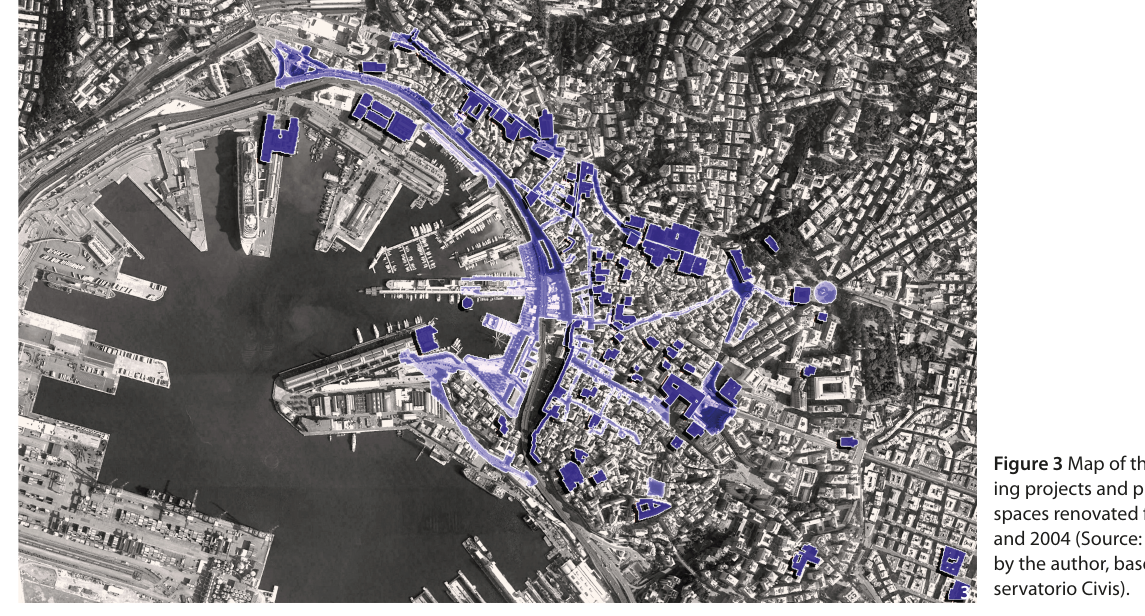
Figure 3 Map of the build- ing projects and public spaces renovated for 2001 and 2004 (Source: drawn by the author, based on Os- servatorio